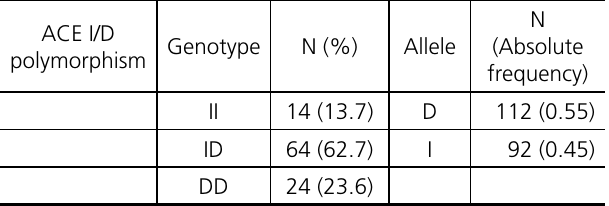
Table 1. Demographic characteristics and clinical features of the studied patients with vein graft atherosclerosis.